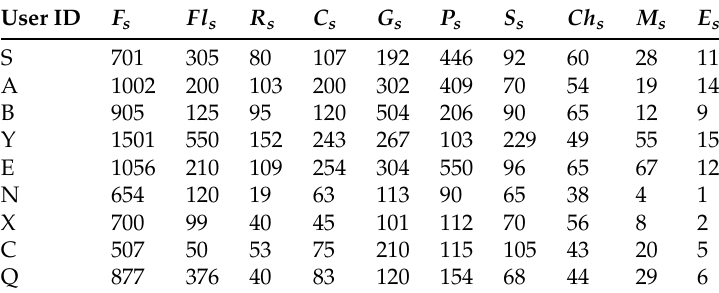
Table 10. Candidate domain values.